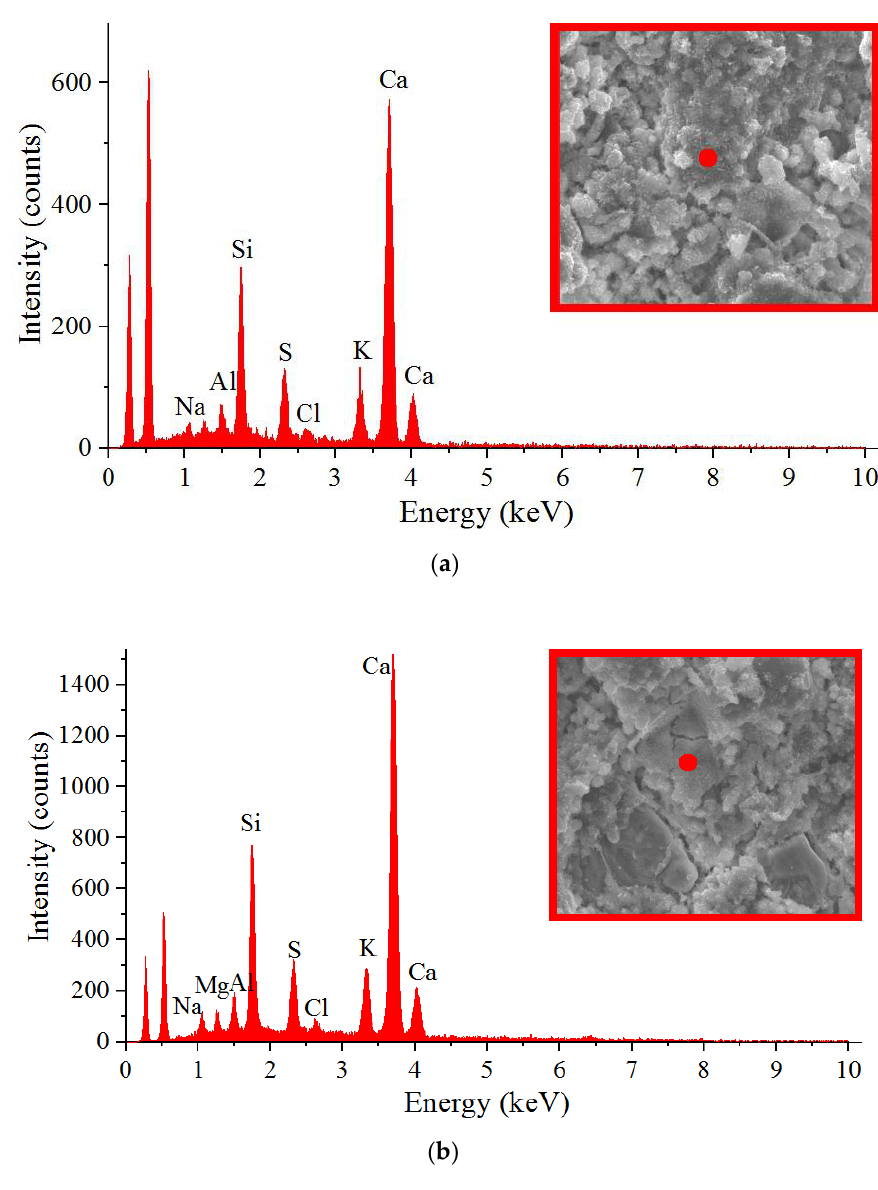
Figure 6. SEM–EDS results for the 20FA0NA ( a ) and 20FA4NA ( b ) after 8 h of curing.